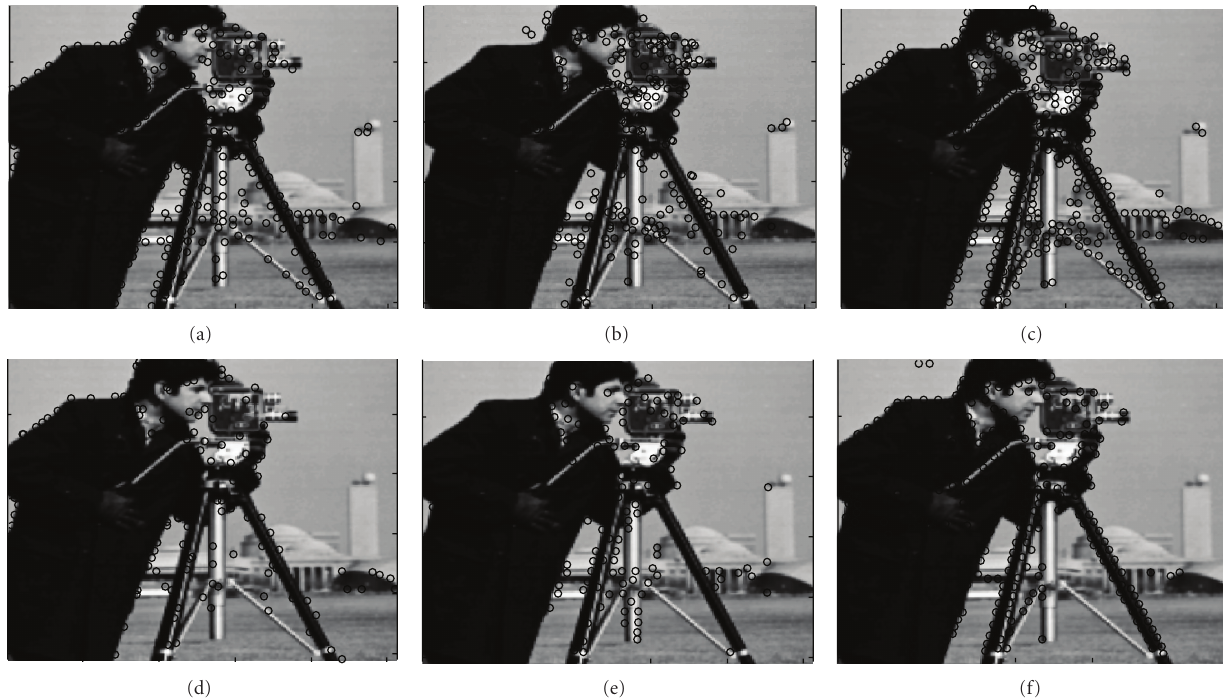
Figure 7: Feature points detected in 1.5 times scaled image by (a) Harris’ method, (b) Lowe’s method, (c) Tomasi’s method, (d) Loupias’ technique, (e) Yeh’s algorithm, and (f) proposed